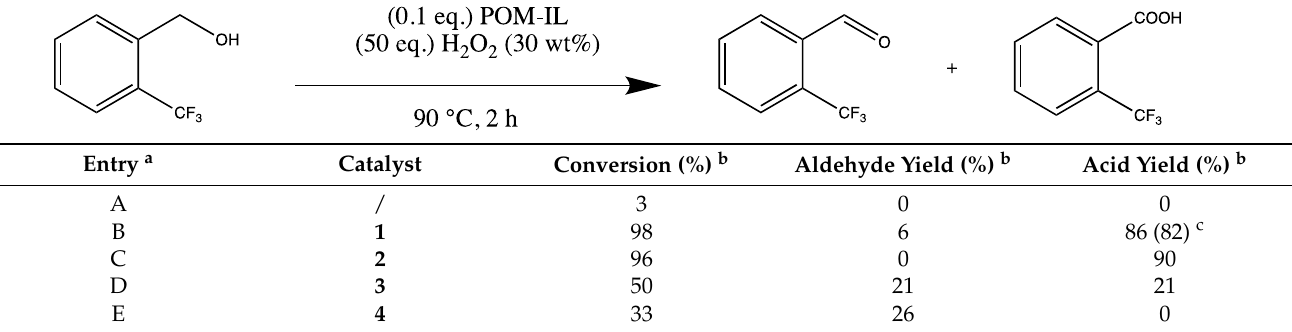
Molecules 2021 , 26 , x FOR PEER REVIEW